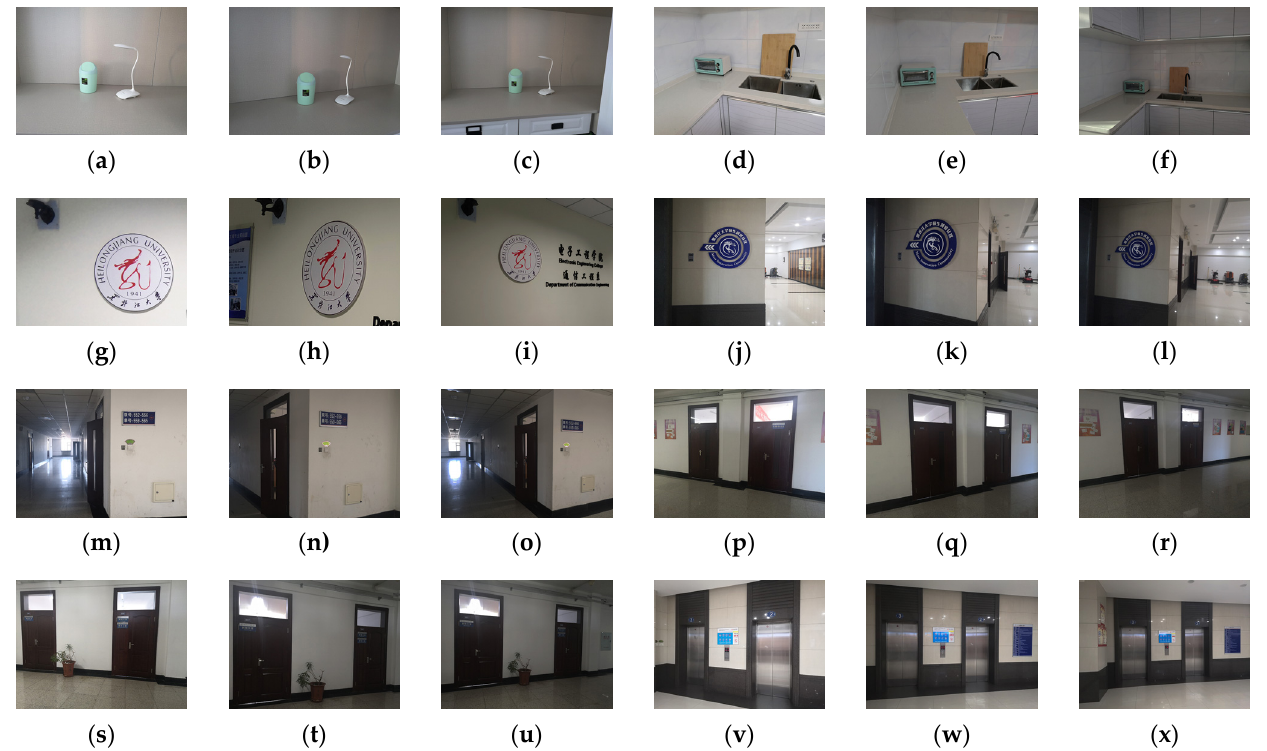
Figure 18. Original image of indoor scene to be matched: ( a , d , g , j , m , p , s , v ) reference images; ( b , e , h , k , n , q , t , w ) images of illumination and affine changes; ( c , f , i , l , o , r , u , x ) images of illumination, scale, and affine changes.